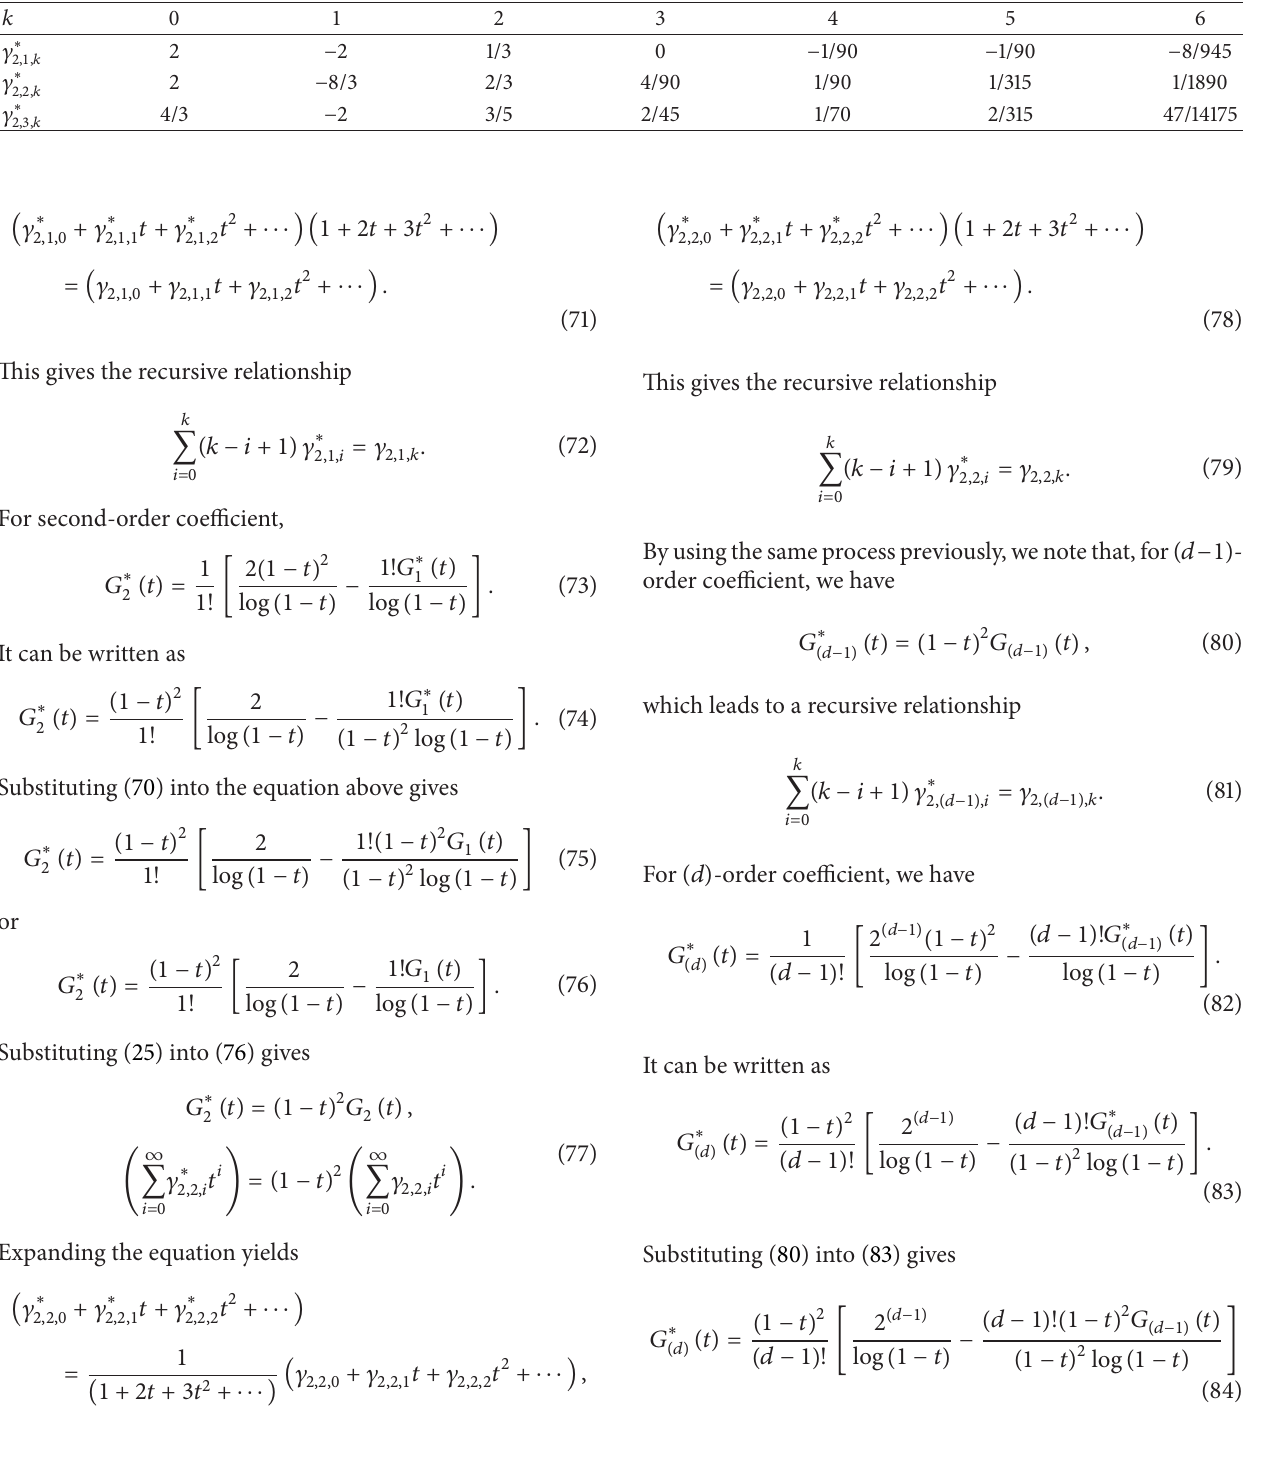
Table 2: The implicit integration coefficients for 𝑘 from 0 to 6 (for 𝑦 𝑛+2